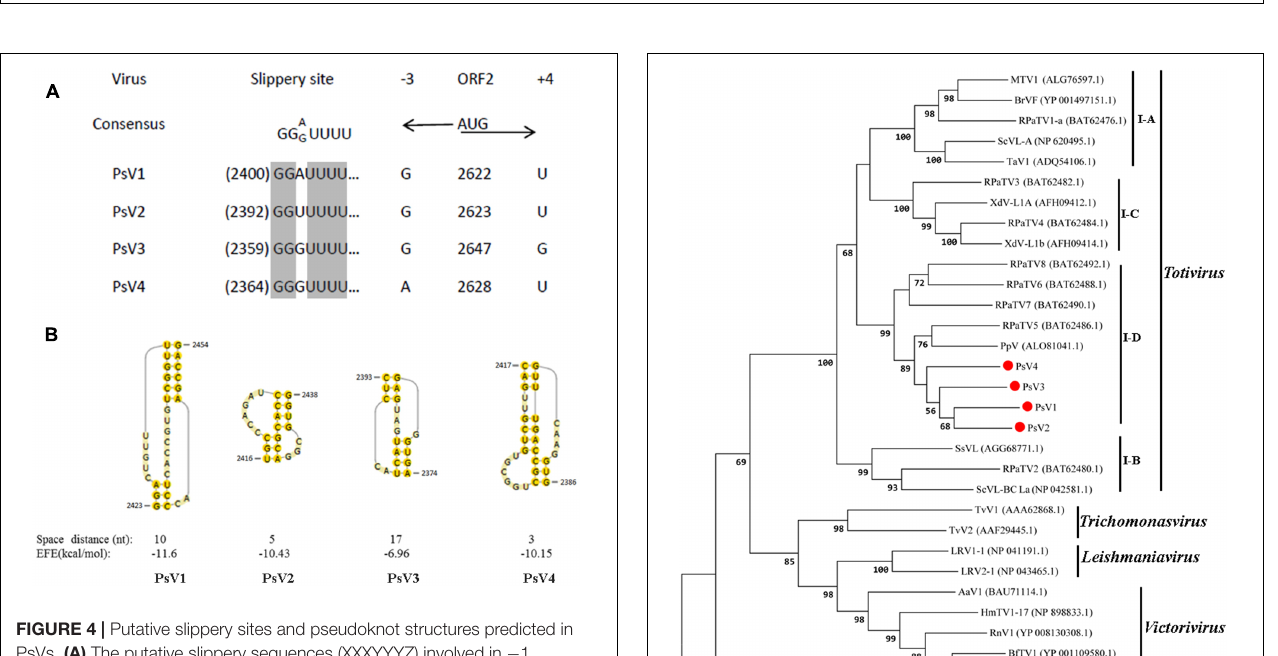
FIGURE 3 | Sequence alignment of PsV RdRp motifs with those of selected viruses in the genus Totivirus . Horizontal lines above the alignment indicate the eight motifs, numbers in brackets suggest the amino acid positions, shadow area and asterisks indicate identical amino acid residues, colons indicate the similar residues.